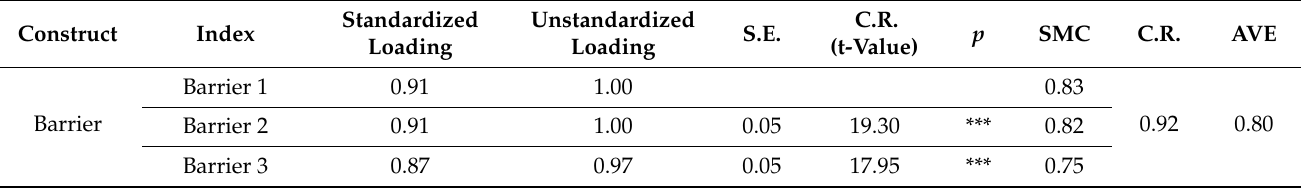
Table 6. Barriers–verification analysis.